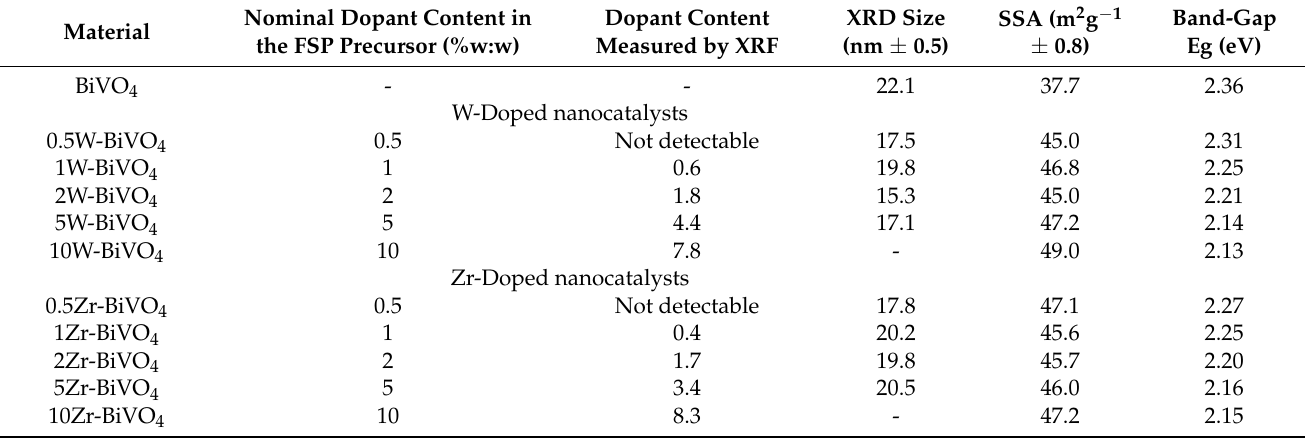
Table 1. Properties of the flame spray pyrolysis (FSP)-made BiVO 4 nanocatalysts